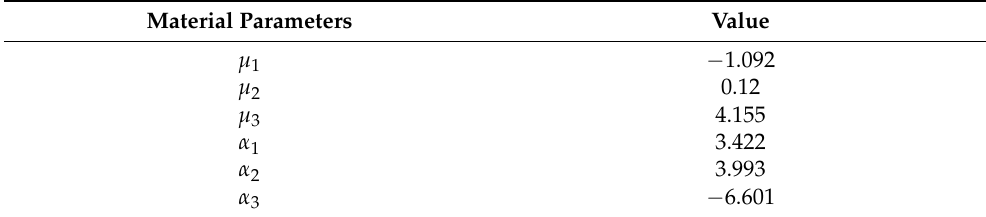
Table 3. Material parameters of the